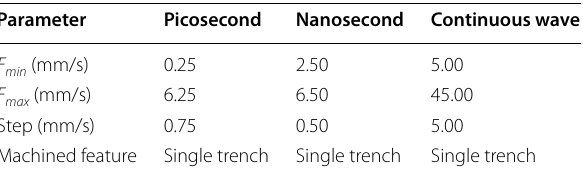
Table 2 Laser machining feed speeds for surface morphology